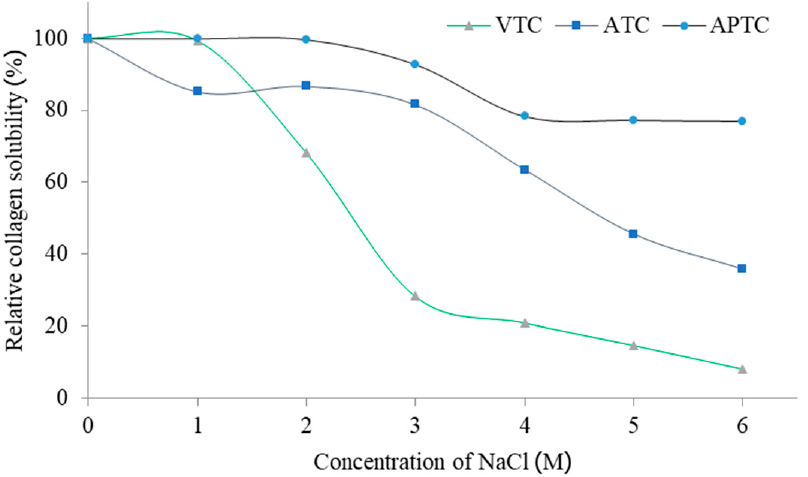
Figure 1. The effect of NaCl on protein solubility of tuna-tendon collagens (VTC: acid-solubilized collagen using vinegar extraction, ATC: acid-solubilized collagen using acetic-acid extraction, and APTC: pepsin-solubilized collagen).